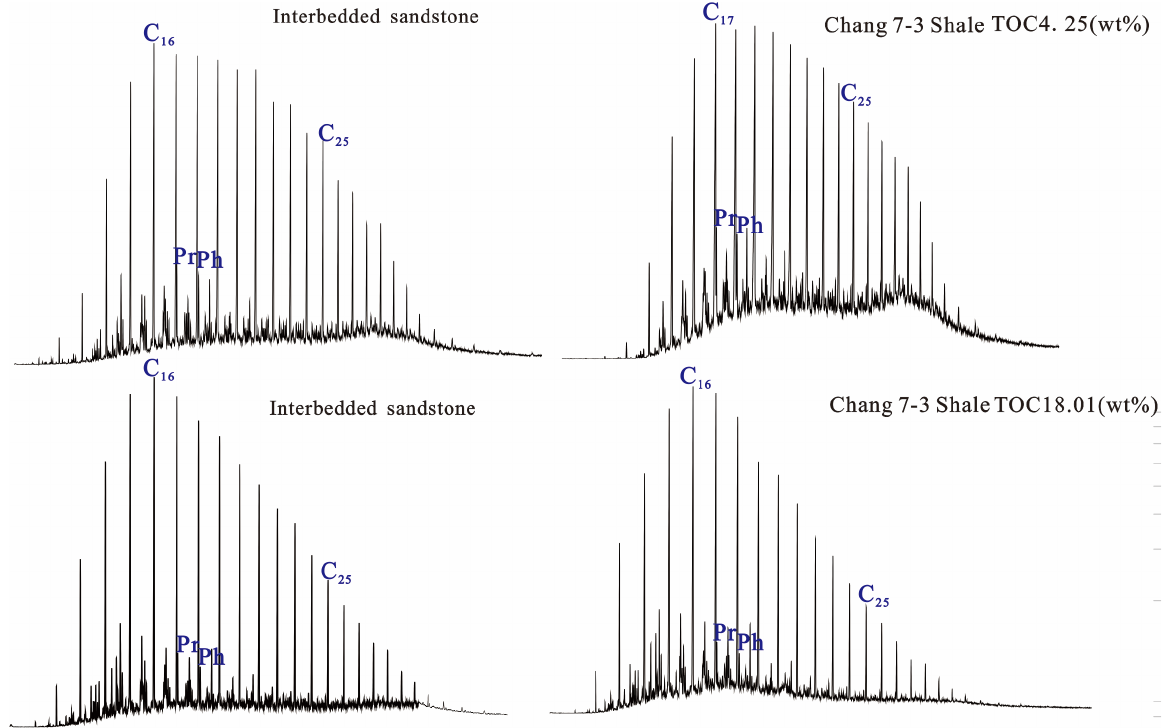
Figure 11. The distribution of saturated fractions in Chang 7-3 shales and juxtaposed sandstones.